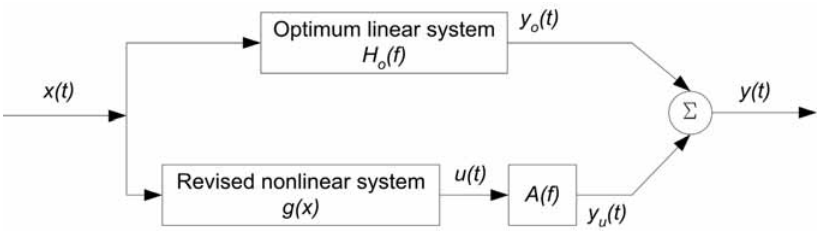
Fig. 2. Nonlinear MISO model with uncorrelated